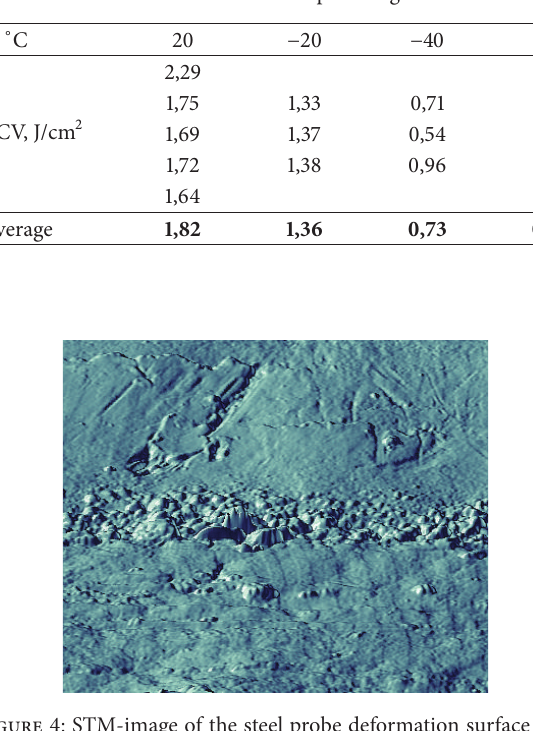
Figure 4: STM-image of the steel probe deformation surface with grain boundary.